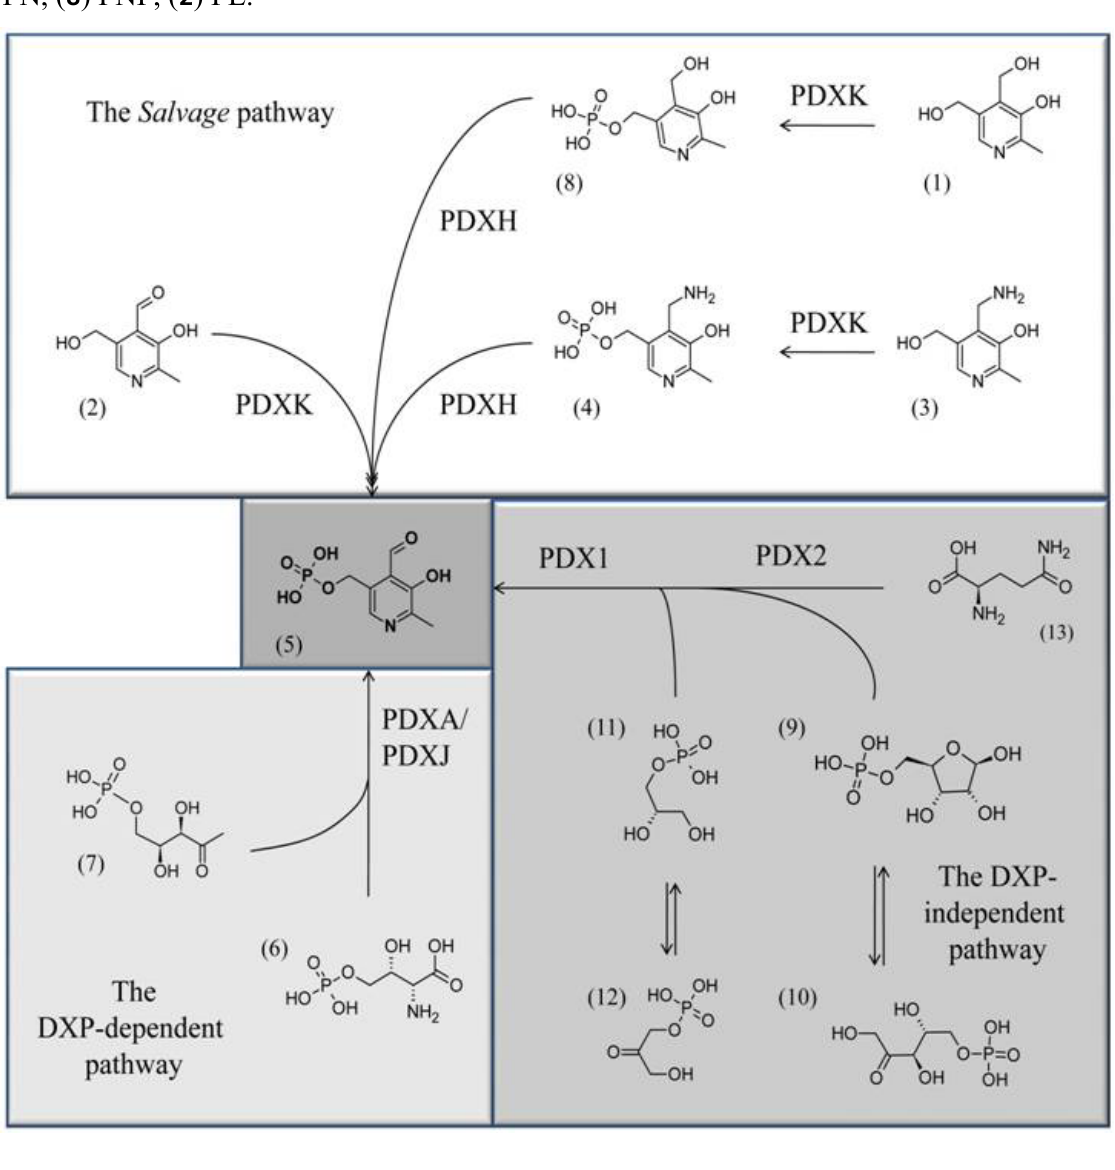
Scheme 1. The three known pathways for PLP biosynthesis: one salvage pathway, and two de novo pathways, a DXP-dependent one and a DXP-independent one. Chemical structures: ( 5 ) PLP; ( 7 ) deoxyxylulose 5’-phosphate, ( 6 ) 4-(phosphohydroxy)- L -